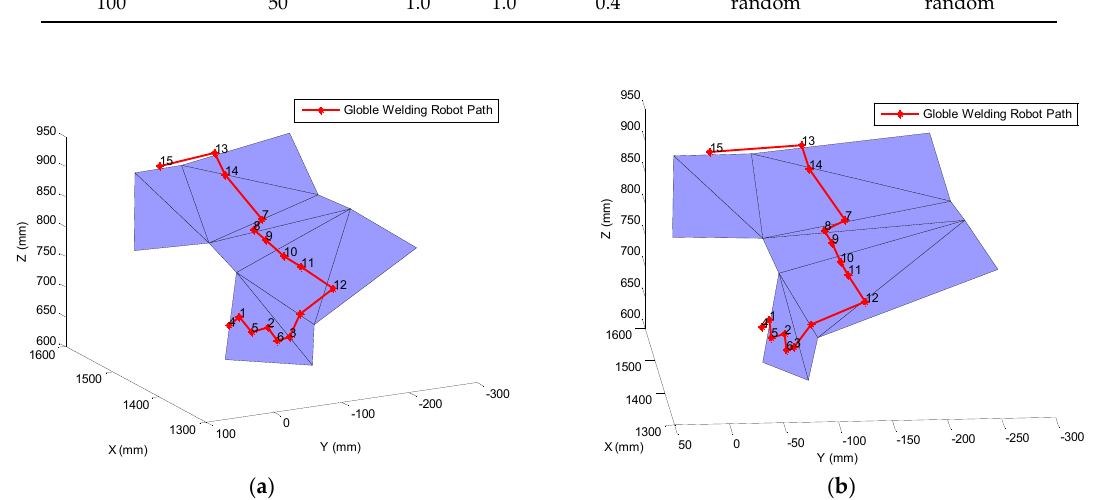
Figure 10. Global path planning with obstacle avoidance. ( a )View A; ( b ) View B. Appl. Sci. 2017 , 7 , 89